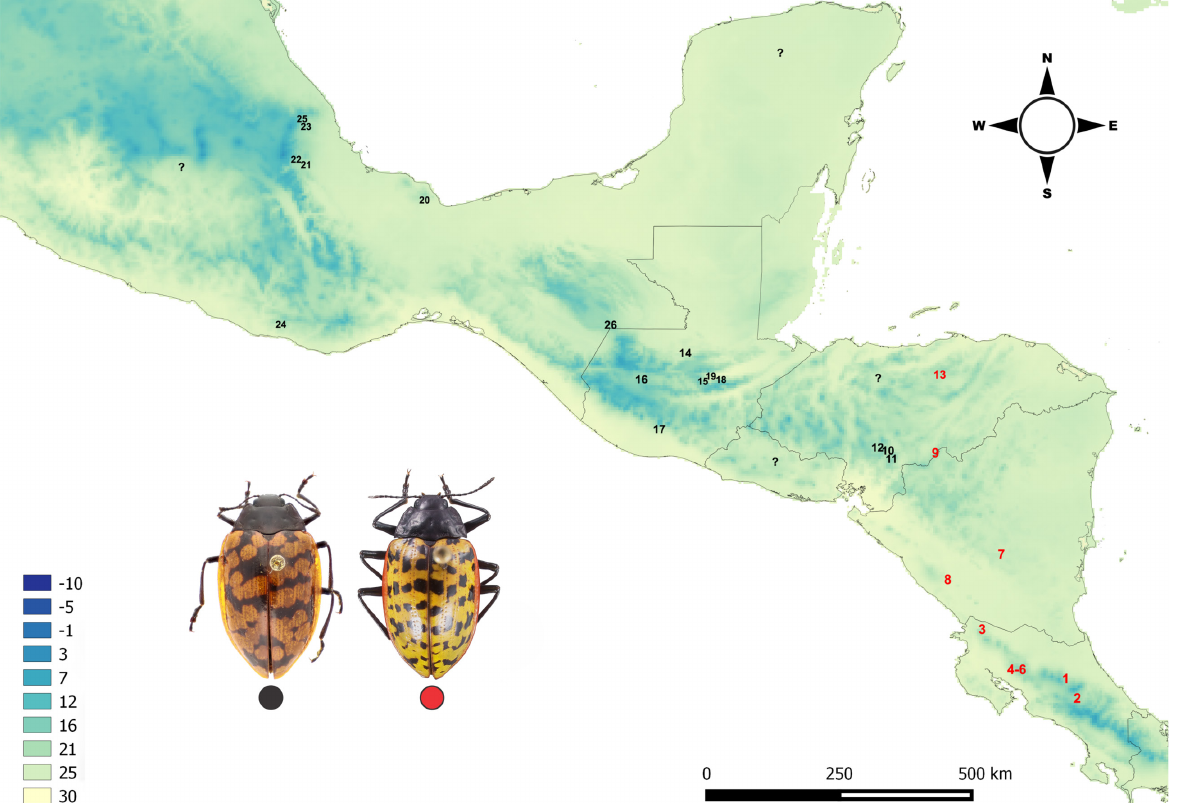
Figure 7. Geographical distribution of Erotylina leoparda (Lacordaire, 1842), at different temperature intervals (Cº). Numbers indicate localities listed in Table I and question marks indicate inaccurate records. Red numbers correspond to variation nicaraguae and black numbers to variation leoparda